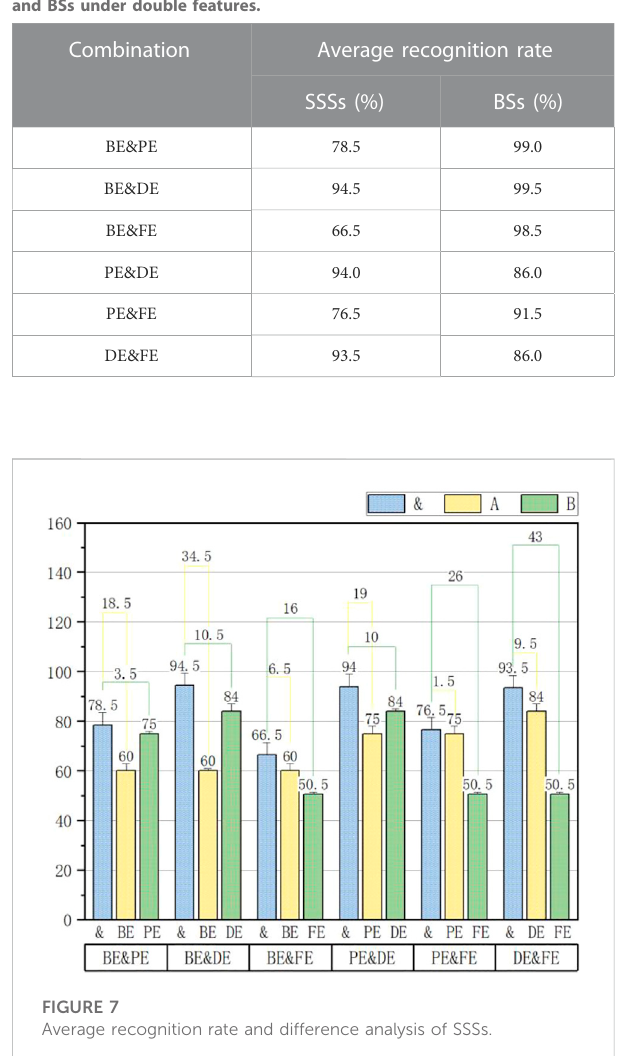
FIGURE 7 Average recognition rate and difference analysis of